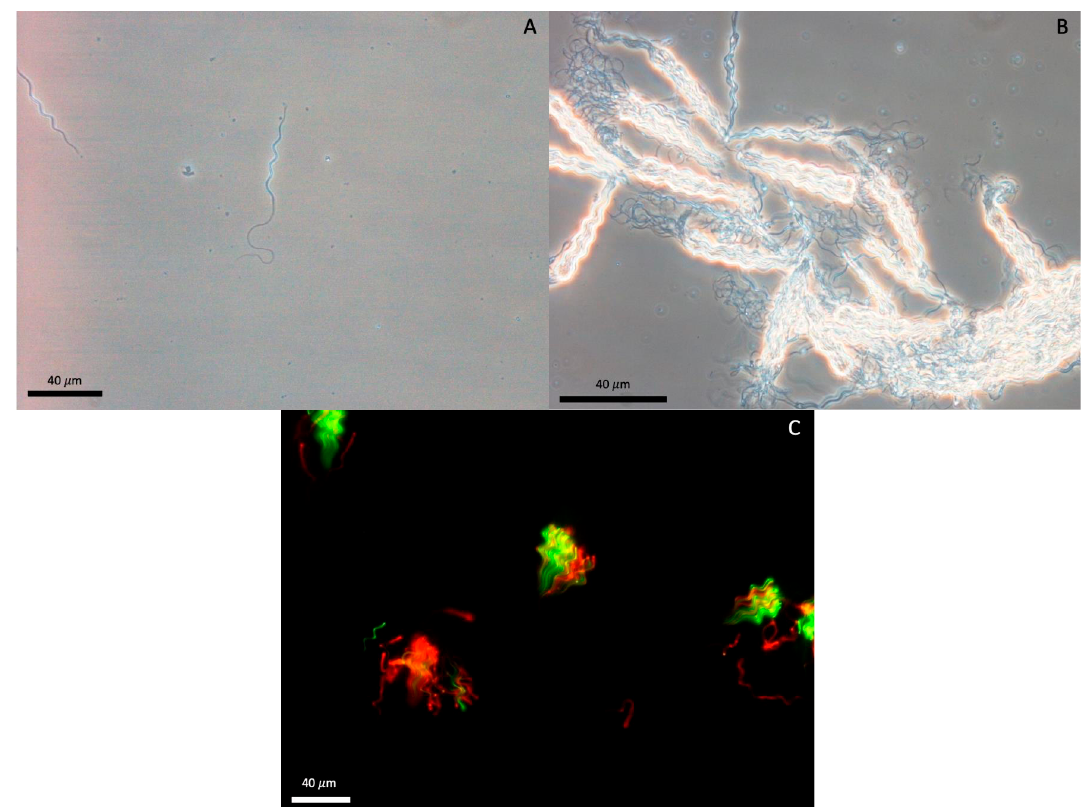
Figure 2. Southern stingray ( Hypanus americanus ) sperm ( A ) composed of a helical head, midpiece and flagellum. Spermatozeugmata ( B ) characterized by organized/aligned sperm bundles. Nuclei ( C ) of southern stingray sperm and spermatozeugmata intact (green) and disrupted (red) plasma membranes.